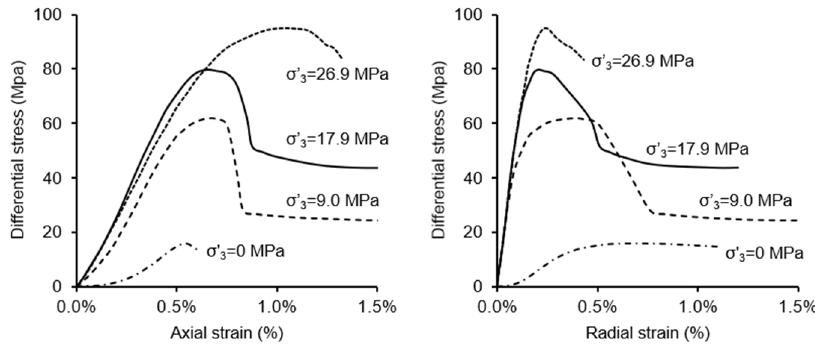
Figure 7. Stress–strain curves from triaxial compression tests on Tamar sandstones.